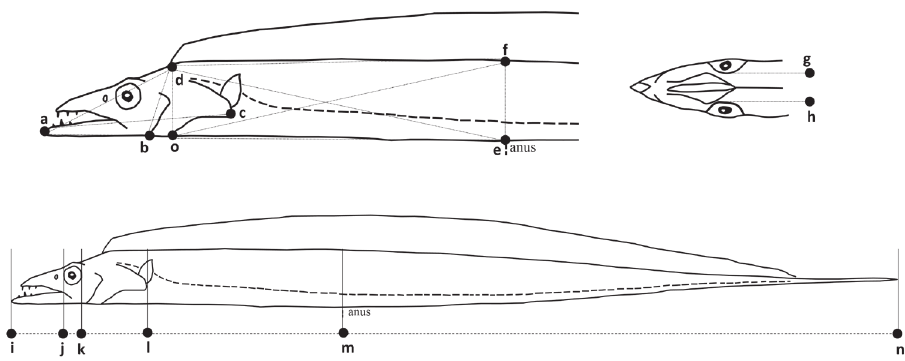
Figure 2. Positions of 14 (a–n) landmarks used to contrast the morphological differences between Trichiurus species.